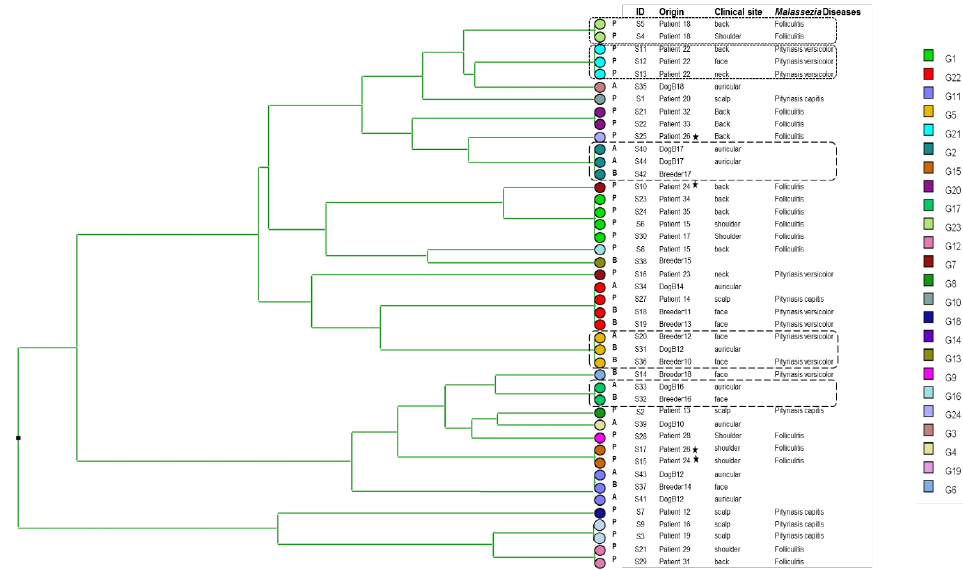
Figure 1. UPGMA dendrogram upon analysis of six VNTR markers obtained from 44 Malassezia globosa isolates. P: patient, A: animal and B: breeder. The highlighted isolates illustrate two epidemiological scenarios (S1 and S2): (S1) for P18 and P22 (square with dotted-line border), isolates collected from different clinical sites share the same genotype, indicating exposure to a clonal Malassezia population. For isolates highlighted by a square with a dashed-line border collected from breeders and their dogs present the same genotype indicating an animal – human co-transmission. (S2) P24 and P26 (star): each isolate has a distinct genotype, indicating exposure to a genetically highly heterogeneous clinical Malassezia population. Typing study by the analysis of six new markers of M. restricta showed a great geno- five (P5) was colonized with strains having the same genotype collected from different sampling sites (back, shoulder) and two breeders shared the same genotype of their dogs (Figure 2).